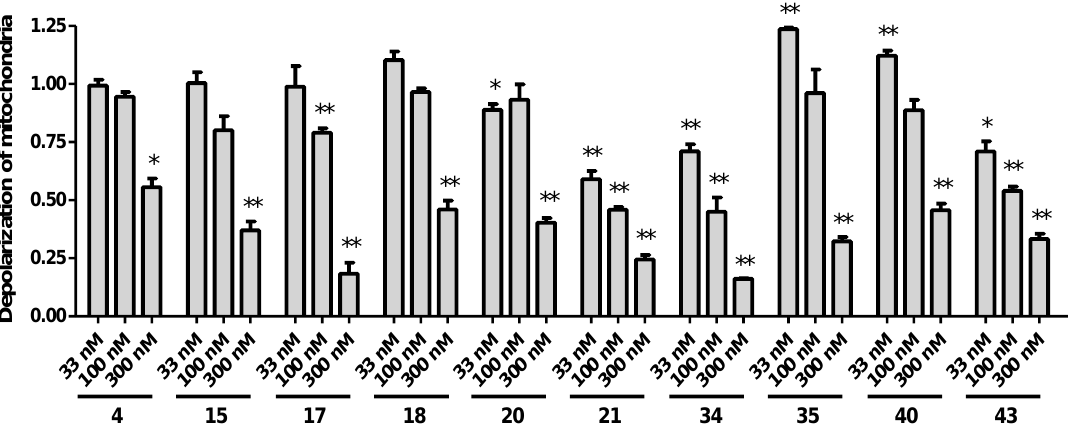
Figure 4. Mitochondrial membrane depolarization assay. Treatment with the synthesized analogs reversed the mitochondrial membrane potential changes caused by oxidative stress. All data was calculated by relation to hydrogen peroxide only treatment set to 1. Statistical significance ( t -test): * p < 0.05 and ** p <